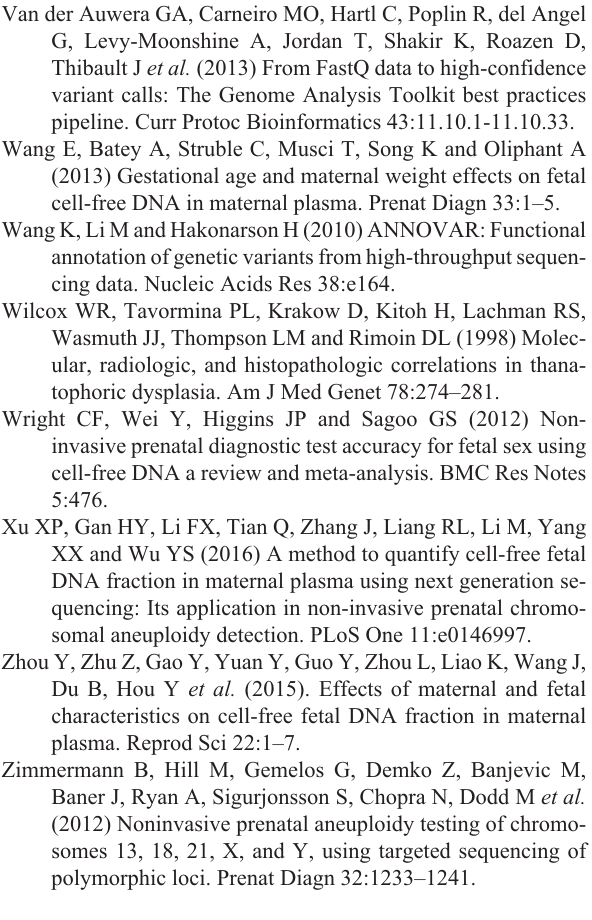
Figure S1 - Fit procedure for FF estimation. Figure S2 - Evaluation of the model according to dif- ferent fetal fractions (FF). Figure S3 - Evaluation of the fitting for mean cover- age value = 150X and SNP numbers = 2000. Figure S4 - Correlations between gestational week, fetal fraction and maternal weight. Table S1 - Genes present in the clinical gene panel. Table S2 - Genes for dysplasia/craniofacial disorders present in the clinical panel. Table S3 - Summary of pregnant samples. Table S4 - Summary of non-pregnant individuals. Table S5 - Summary of mock